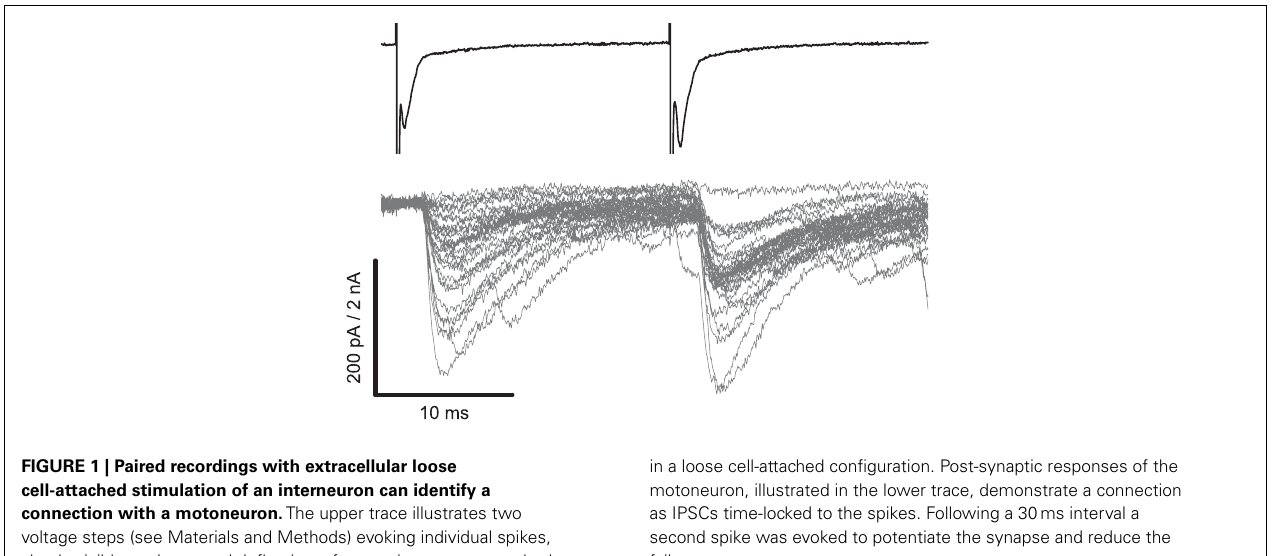
in a loose cell-attached configuration. Post-synaptic responses of the motoneuron, illustrated in the lower trace, demonstrate a connection as IPSCs time-locked to the spikes. Following a 30ms interval a second spike was evoked to potentiate the synapse and reduce the failure